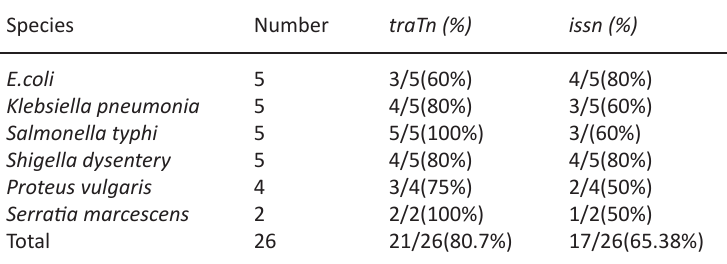
Table 3. The occurrence of virulence factors genes among bacterial species.